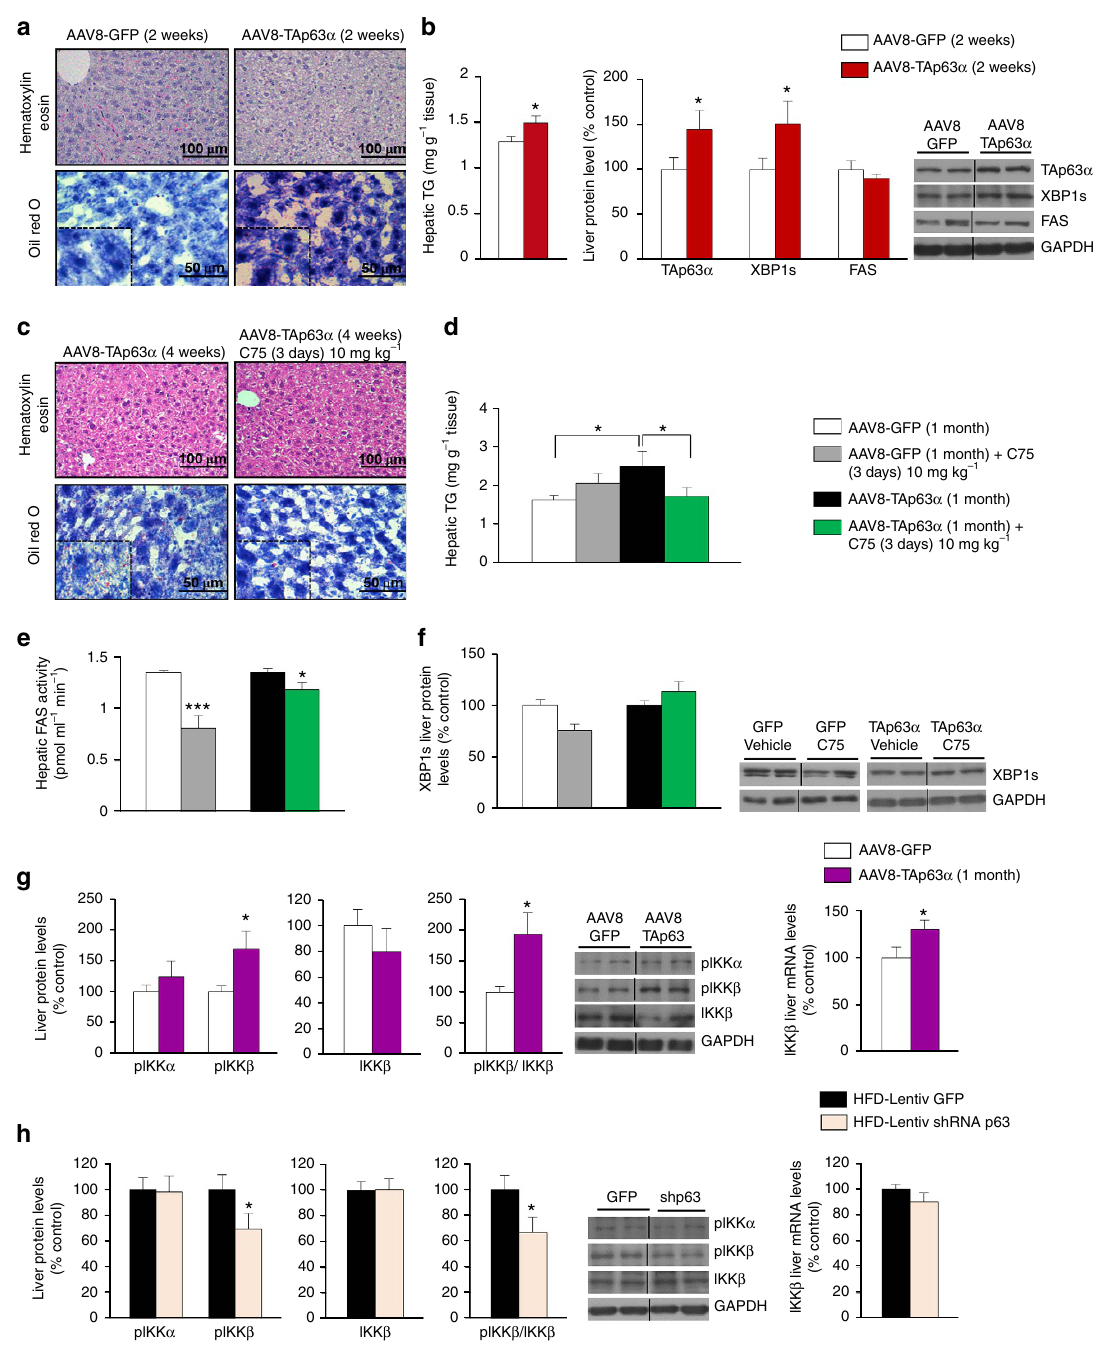
Figure 7 | TAp63 a -induced ER stress precedes changes in FAS expression and IKK b links p63 to ER stress. ( a ) Representative photomicrographs of hematoxylin-eosin (upper panel) and oil red O staining (lower panel) of mice liver sections ( n ¼ 3 per group); ( b ) total liver TG content and protein levels of TAp63 a , XBP1s and FAS in the liver of mice 2 weeks after hepatic over-expression of TAp63 a ( n ¼ 6 per group). ( c ) Representative photomicrographs of hematoxylin-eosin (upper panel) and oil red O staining (lower panel) of mice liver sections ( n ¼ 3 per group); ( d ) total liver TG content ( n ¼ 8 per group); ( e ) hepatic FAS activity ( n ¼ 8 per group); and ( f ) protein levels of XBP1s in the liver of mice injected with AAV over-expressing TAp63 a treated with the FAS inhibitor C75 ( n ¼ 7 per group). ( g ) pIKK a , pIKK b , IKK b protein and mRNA levels in the liver of mice after 2 or 4 weeks of the tail vein injection of an AAV8 over-expressing either GFP or TAp63 a isoform ( n ¼ 7 per group). ( h ) pIKK a , pIKK b , IKK b protein and mRNA levels in the liver of mice after a tail vein injection of a lentiviral particle that encodes either GFP or a shRNA p63 ( n ¼ 7 per group). Protein GAPDH levels were used to normalize protein levels and control values (AAV8 GFP) were normalized to 100%. Dividing lines indicate splicings in the same gel ( n ¼ 7 per group). Uncropped blots of this Figure accompanied by the location of molecular weight markers are shown in Supplementary Fig. 17. Data are presented as mean ± standard error mean (s.e.m.). Statistical differences are denoted by * P o 0.05, ** P o 0.01 and *** P o 0.001. For multiple comparison ( d ) a one way ANOVA followed by Bonferroni or Kruskal-Wallis test was performed. Student t -test was used in the other panels.